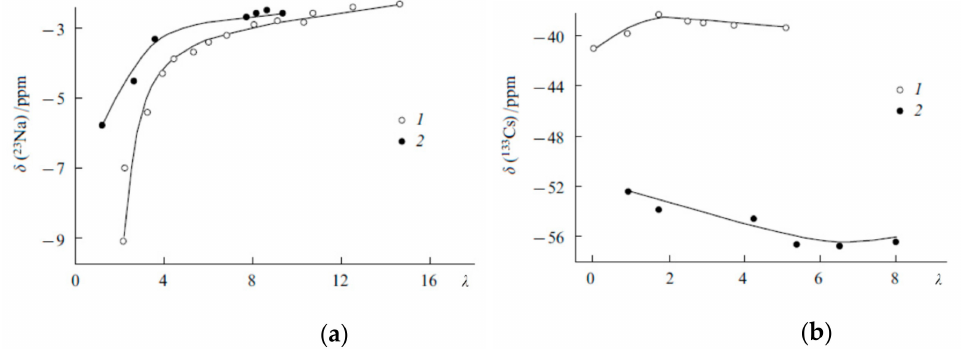
Figure 15. Chemical shifts in 23 Na NMR ( a ) and 133 Cs NMR ( b ) spectra vs. the moisture content of perfluorinated sulfonate cation-exchange membranes MF-4SC (1) and carboxylic membranes F-CF (2). Reprinted with permission from [21]. Copyright 2010 Springer